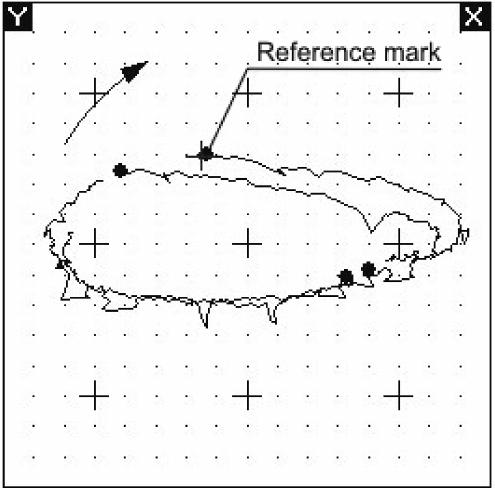
Fig. 13. Journal orbits measured on bearing #1 during an event of abnormal vibrations of the HP-IP turbine.